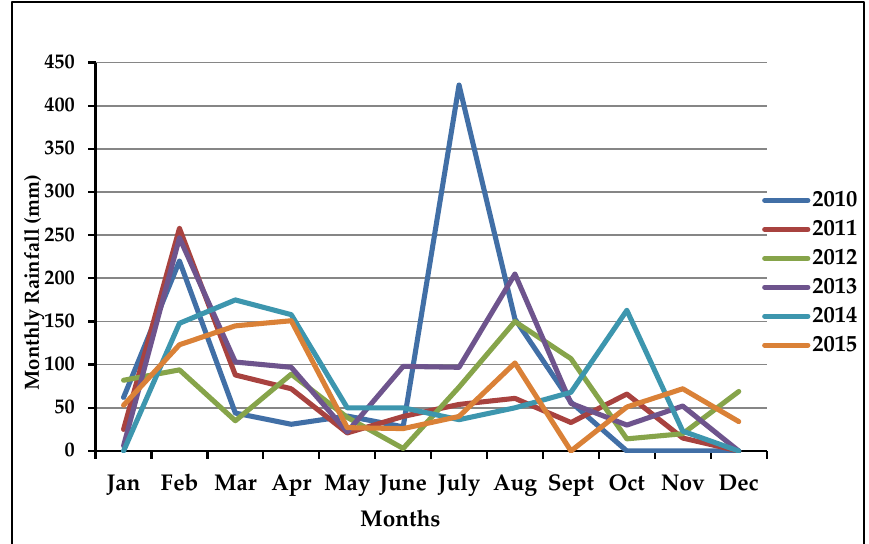
Figure 6. Average monthly rainfall distribution in the study area (2010–2015).